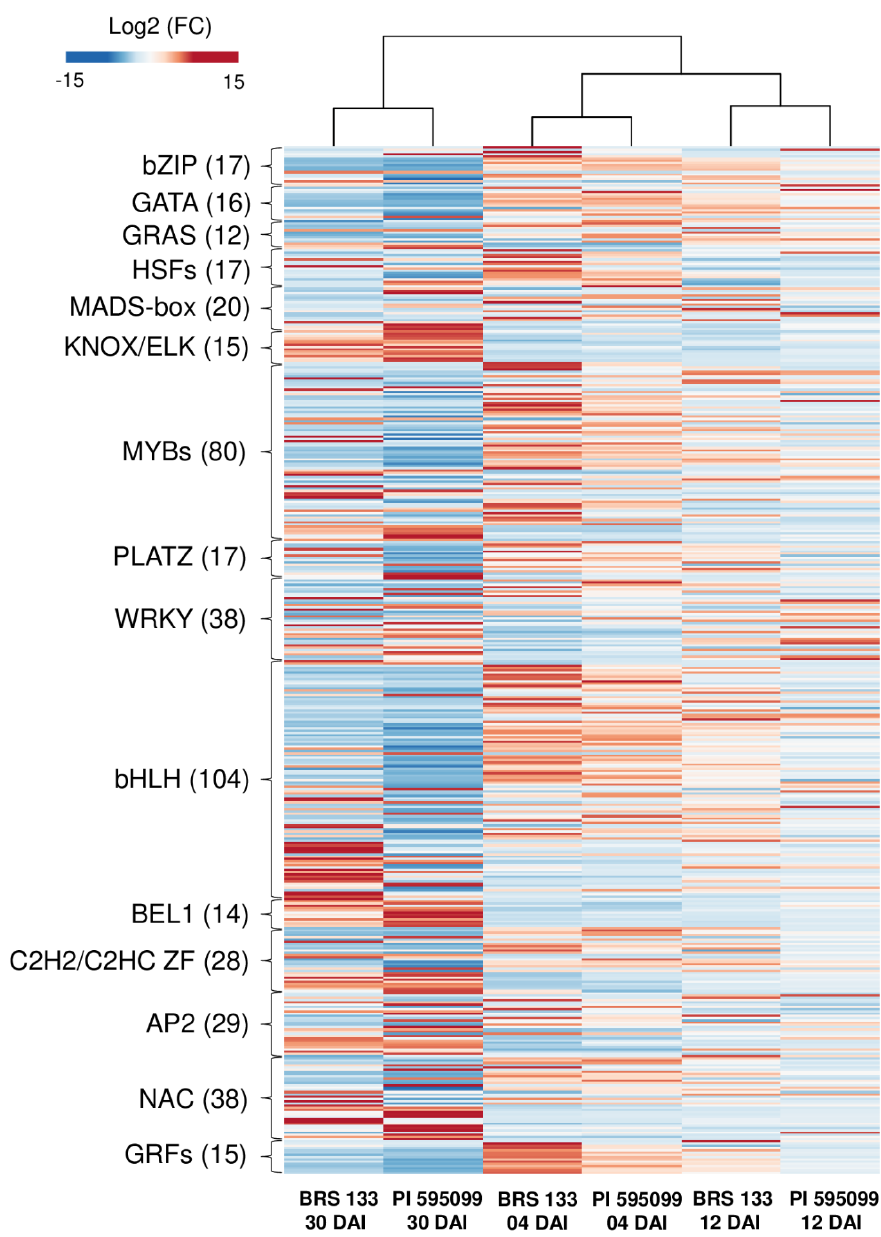
Figure 5. Distribution of differentially expressed genes encoding transcription factors (TFs) in the transcriptomes of genotypes BRS 133 and PI 595099 infected with M. incognita . In the heatmap are clusters of the following families of TFs: basic leucine zipper domain (bZIP), GATA family (GATA), GRAS-domain (GRAS), heat shock factors (HSFs), DNA-binding MADS domain (MADS-box), KNOX/ELK homeobox (KNOX/ELK), DNA-binding domain MYB domain (MYBs), plant AT-rich sequence- and zinc-binding (PLATZ), DNA-binding domain WRKY domain (WRKY), basic helix-loop-helix TFs (bHLH), homeobox protein BEL1 (BEL1), c2h2/c2hc zinc fingers (C2H2/C2HC ZF), apetala 2 (AP2), DNA-binding domain NAC domain (NAC) and growth regulating factors (GRFs). Numbers shown in parentheses after the TF families correspond to the number of DEGs. The susceptible genotype BRS 133 and the highly tolerant genotype PI 595099 are represented at the bottom of the chart. Column clusters were generated based on Euclidean distances. Values of fold-change (FC) for each genotype are given in comparison to the time zero [0 days after inoculation (DAI) with M. incognita ] of the corresponding